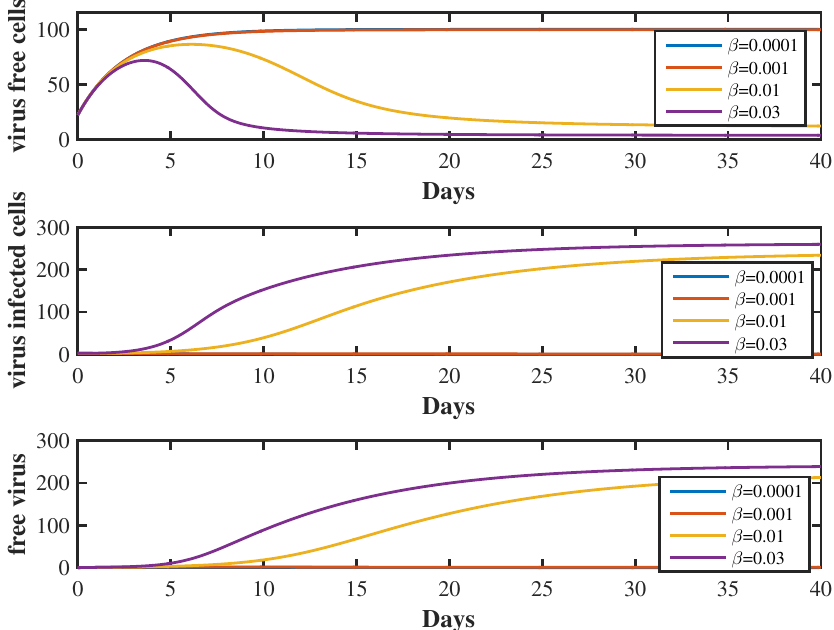
Figure 4. Numerical solution of the model (2) when fixing α = 0.9 and with different β values. In Figure 5, we use the same initial condition and data but fix α = 0.4 with different values of π v . We find that the number of virus-free cells decreases and all numbers of the virus-infected cells and virus-free cells increases, while the solution of the model (2) approaches e 2 , which means that the e 1 becomes unstable.